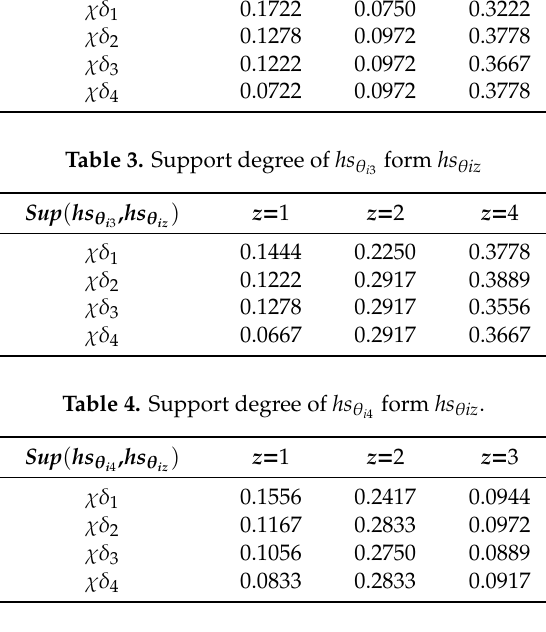
form hs θ iz i 3